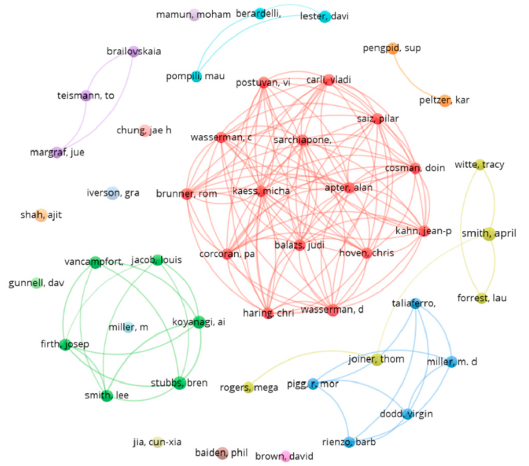
Figure 2. Top 48 most prolific co-authors and their relationships.